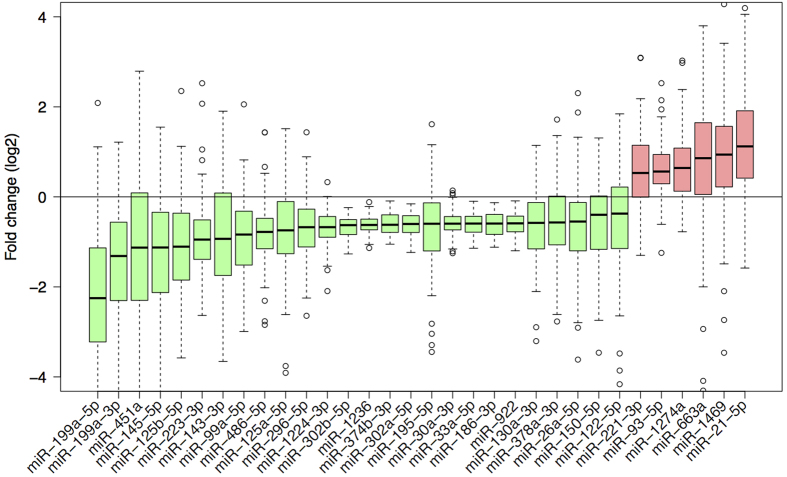
miRNAs with a statistically significant differential expression between tumorous and adjacent non-tumorous tissues of 100 HCC patients (absolute FC >1.5 and FDR < 0.05).